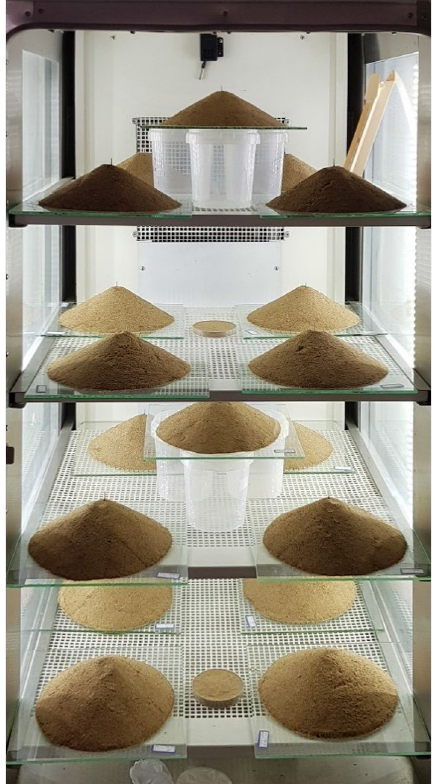
Figure 3. Treated sand dunes in an incubator (kept at 30